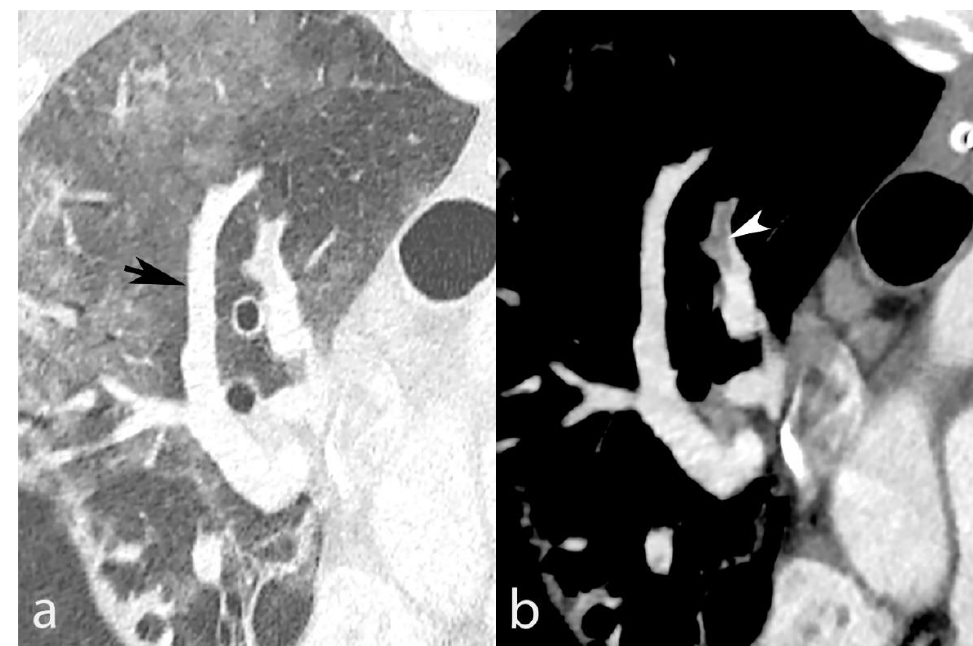
Figure 6. COVID-19 pneumonia with AO and VC (panel ( a ), black arrow) in a 63-year-old man. Acute PE (panel ( b ), white arrowhead) was found in the right upper lobe. The concomitant presence of PE and VC raises the question of arteriovenous anastomosis dysregulation increasing blood flow in the vein despite the arterial obstruction.